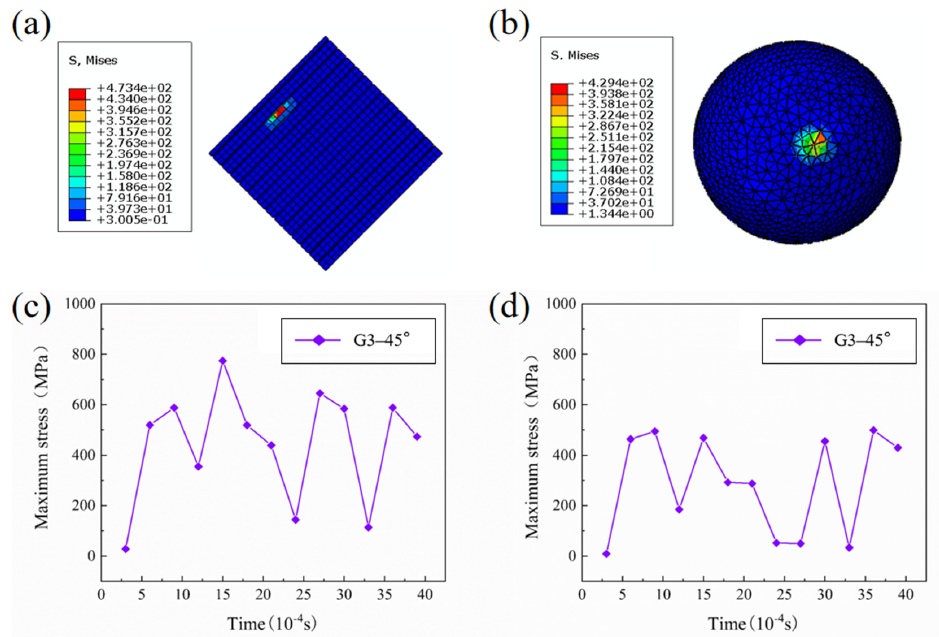
Figure 7. When the sliding orientations was 45°, ( a ) and ( c ) show the simulation results of YG6X. ( b ) and ( d ) are the simulation results of TC4.